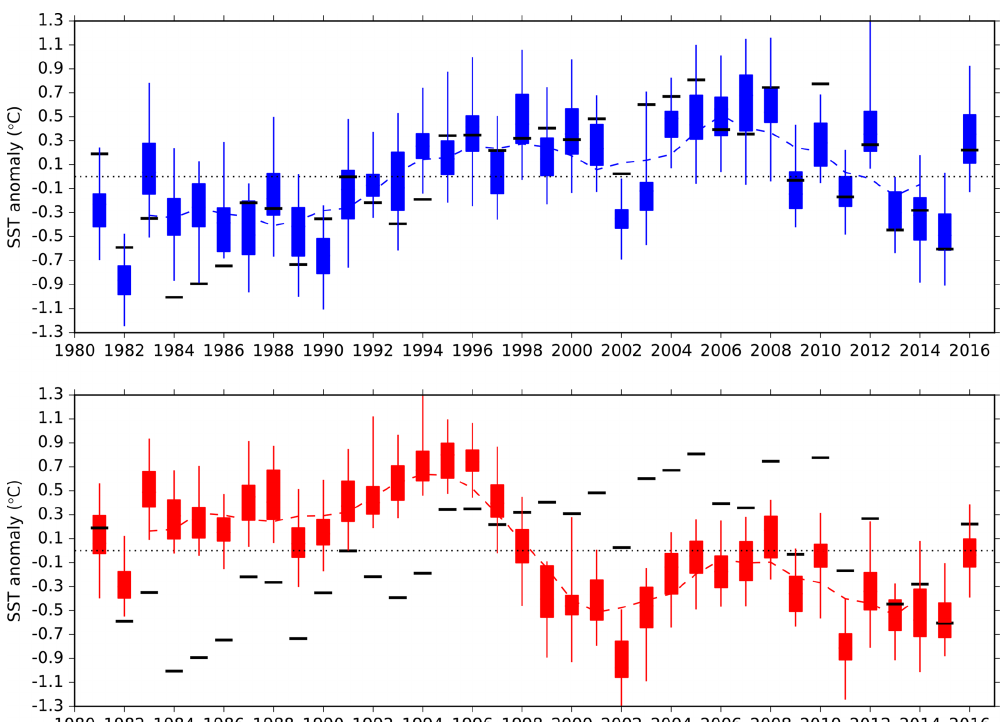
Figure 7. DJF time series of SST anomaly in a northwest Atlantic region: 40 to 60 ◦ N, 50 to 30 ◦ W (illustrated as a grey box in Fig. 6) at 1 month forecast lead. Quartiles, minimum and maximum of the SEAS4 25-member ensemble are shown in blue, while the SEAS5 25- member ensemble is shown in red. The black bars indicate ERA-Interim reanalysis. A 5-year running mean for each system is shown as a dashed line. Forecasts were initialised in November, and the year shown is the year the ensemble was